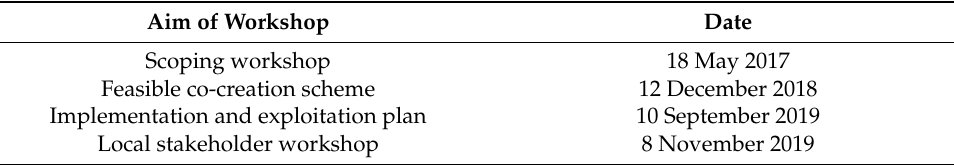
Table A1. List of workshops.